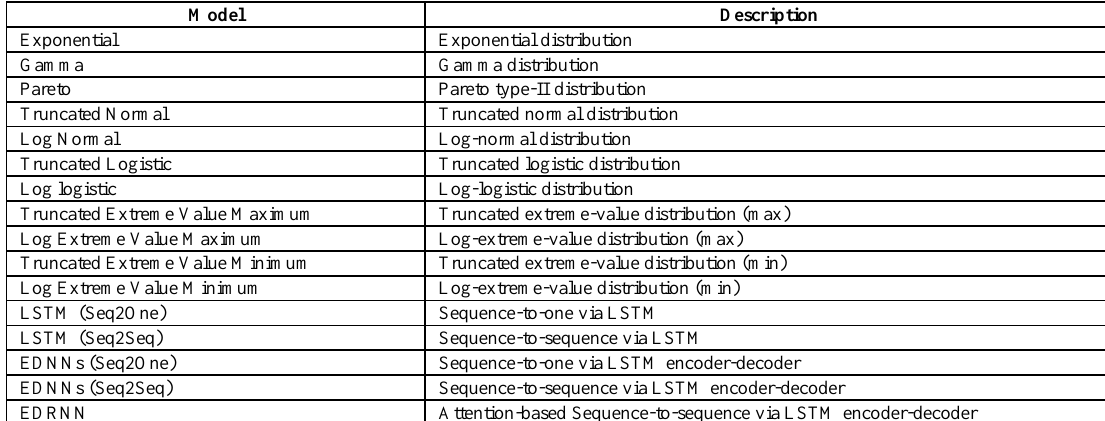
Table 3. Description of the baseline